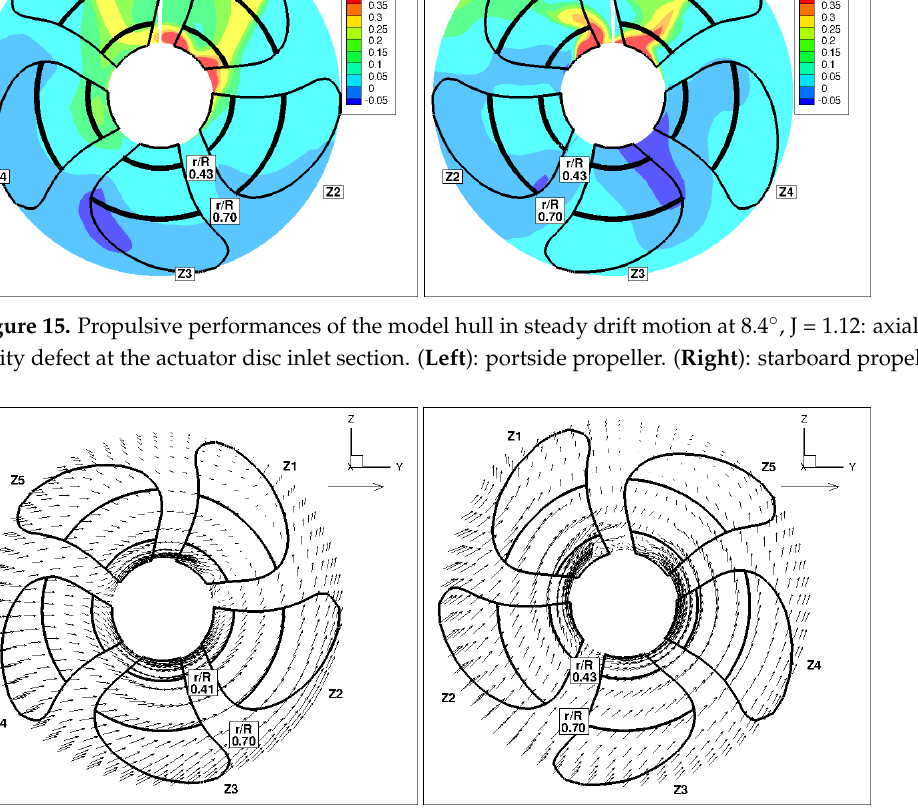
Figure 16. Propulsive performances of the model hull in steady drift motion at 8.4 ◦ , J = 1.12: in-plane velocity component through vectors at the actuator disc inlet section. ( Left ): portside propeller. ( Right ): starboard